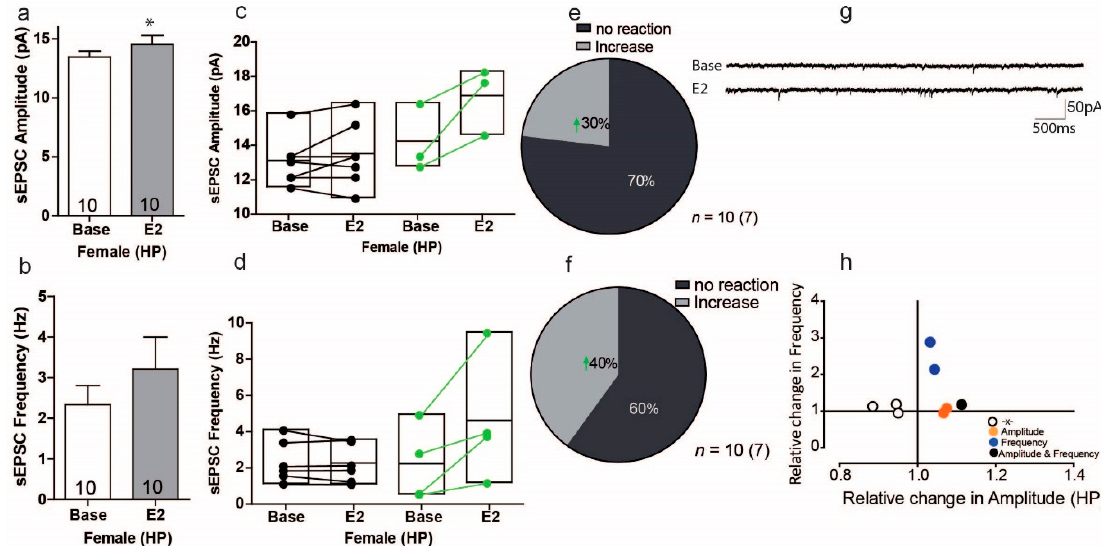
Figure 7. Estradiol enhances sEPSC amplitude and frequency in a subgroup of cells in the hippocampus of female mice. ( a , c ) Significant changes were found in the average sEPSC amplitudes but not in the sEPSC frequency recordings during baseline and after E2 treatment. ( b , d ) Within-cell analyses showed that some cells significantly responded to E2 in sEPSC amplitude and sEPSc frequency. ( e , f ) The proportion of cells that responded to E2 treatment in sEPSC amplitude and sEPSC frequency. ( g ) Sample traces, frequencies and amplitudes of sEPSCs before and after DPN treatment. ( h ) No correlations between changes in sIPSC frequency and sIPSC amplitude were found; * HP, Hippocampus.